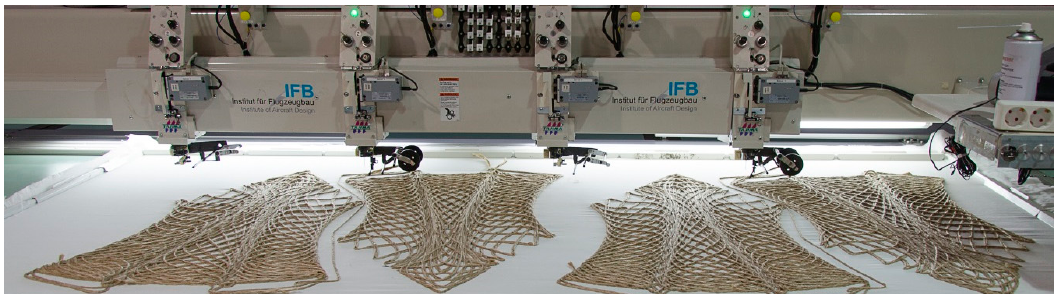
Figure 13. Fabrication of multiple legs on a Tajima machine.